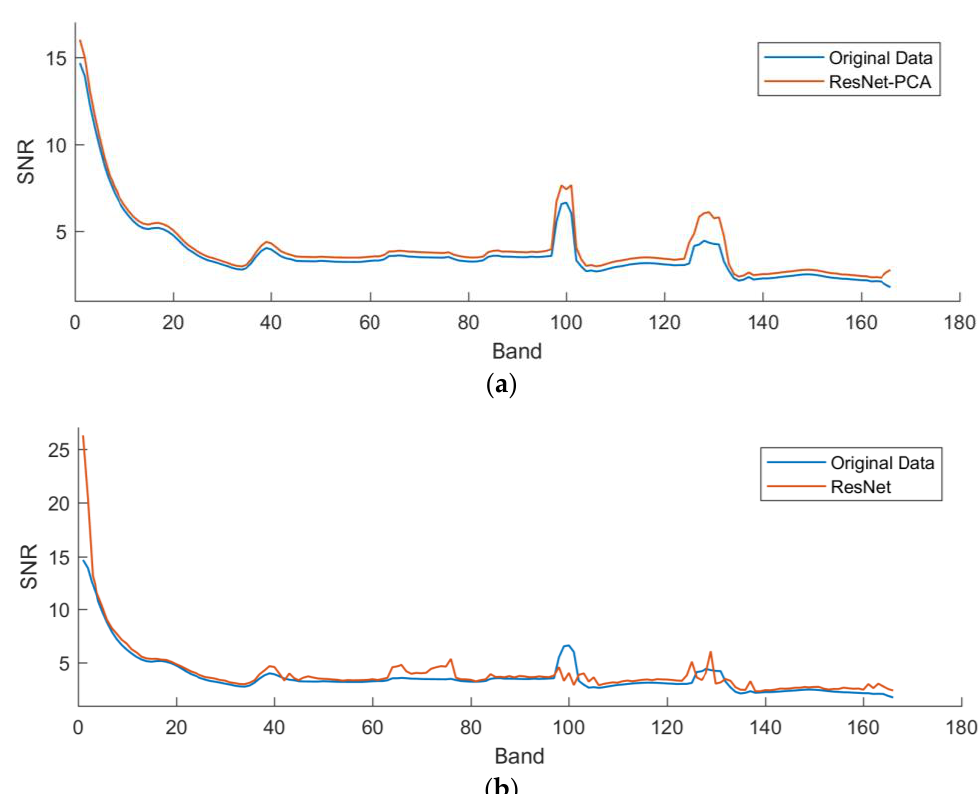
Figure 6. SNR comparison between SRE-ResNet and ResNet for Dataset I. ( a ) SRE-ResNet, ( b ) ResNet.